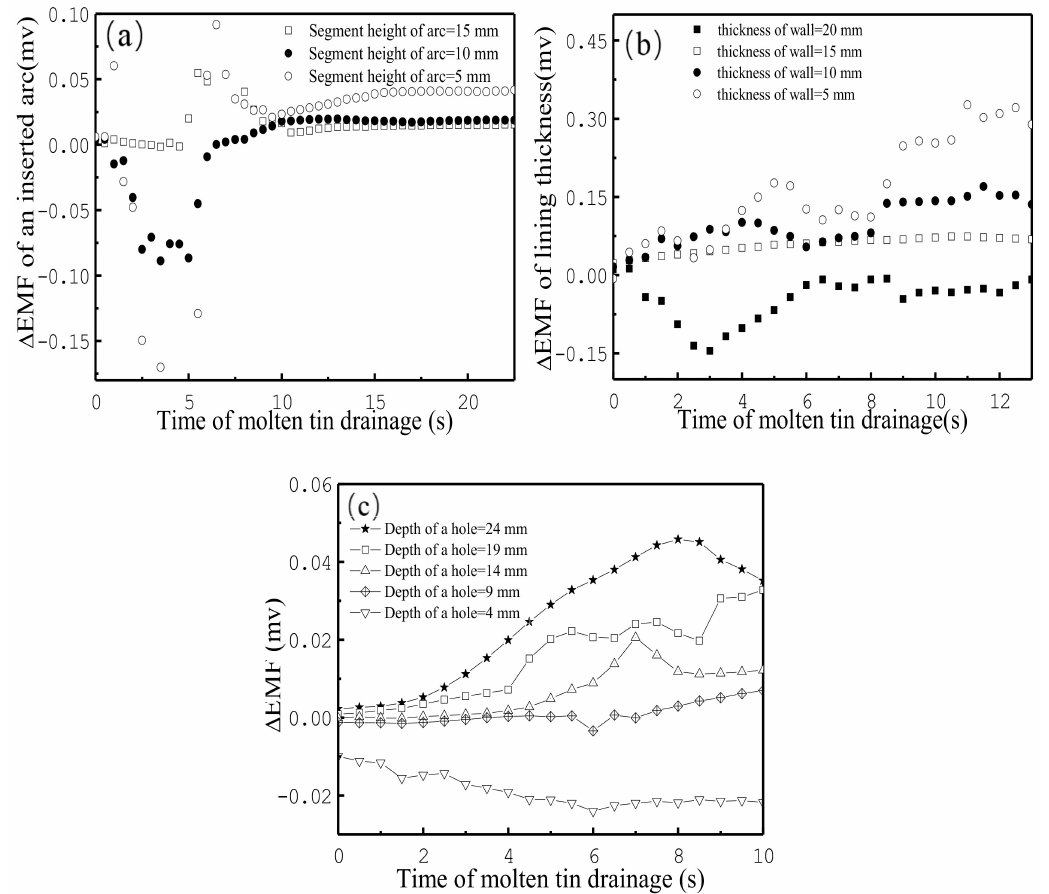
Figure 8. Results of three di ff erent scenarios: ( a ) three arc inserts; ( b ) four di ff erent thicknesses along the circumference; and ( c ) five depths in a hole in the wall of the vessel: 24, 19, 14, 9, and 4